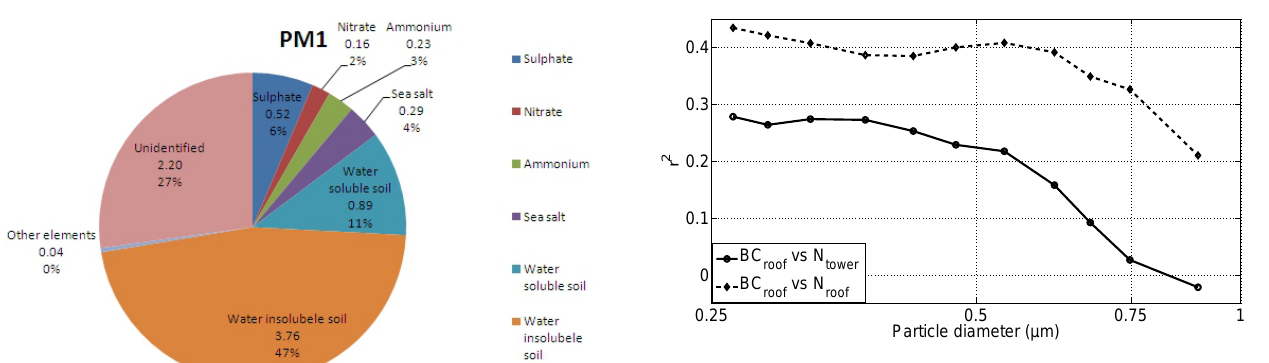
Fig. 7. Correlation coefficients between; BC concentrations mea- sured on roof level with size resolved number concentration on roof level (dashed line); heated, size resolved number concentration on tower level (solid